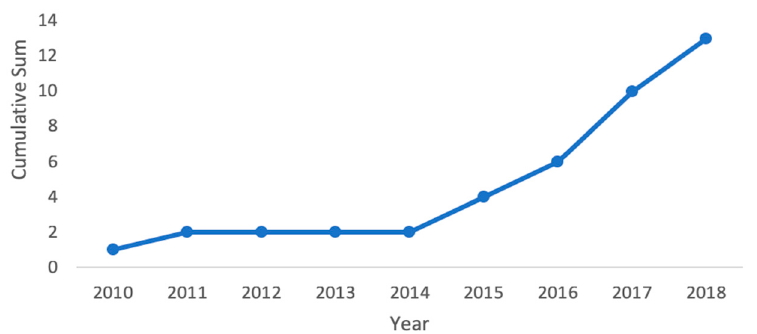
Figure 4. Cumulative count of multi-site PPG BP related studies from January 2010 to January 2019 showing an increase in the number of studies.